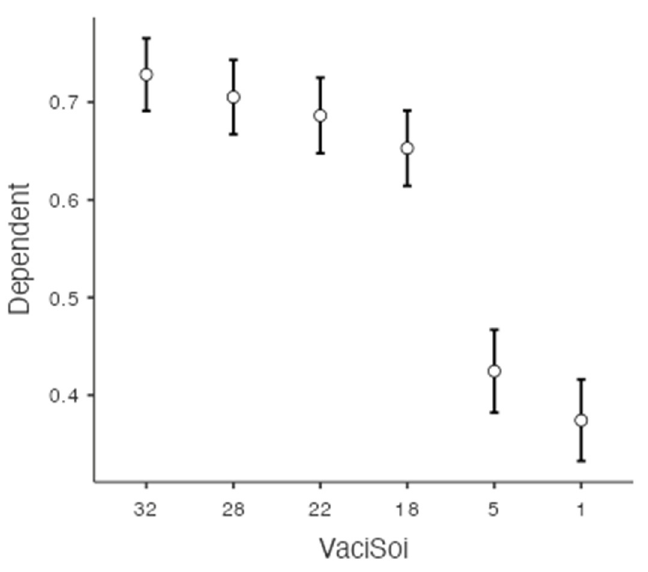
Figure 1. Scores for intention to get vaccinated according to the scenarios. Note: Dependent = Score for decision to get vaccinated; 32 = Scenario 32 (No modalities in “High uncertainty”); 28 = Scenario 28 (Mode of transmission: Remains unknown); 22 = Scenario 22 (Consequences: Whose long term consequences are unknown; and Effectiveness of the vaccine: We only have partial data on its effectiveness); 18 = Scenario 18 (Consequences: Whose long term consequences are unknown; Mode of transmission: Remains unknown; and Effectiveness of the vaccine: We only have partial data on its effectiveness); 5 = Scenario 5 (Knowledge about the virus: Recently discovered and not well known; Consequences: Whose long term consequences are unknown; Effectiveness of the vaccine: We only have partial data on its effectiveness; and Side effects: We do not yet know the risks of side effects); 1 = Scenario 1 (Knowledge about the virus: Recently discovered and not well known; Consequences: Whose long term consequences are unknown; Mode of transmission: Remains unknown; Effectiveness of the vaccine: We only have partial data on its effectiveness; and Side effects: We do not yet know the risks of side